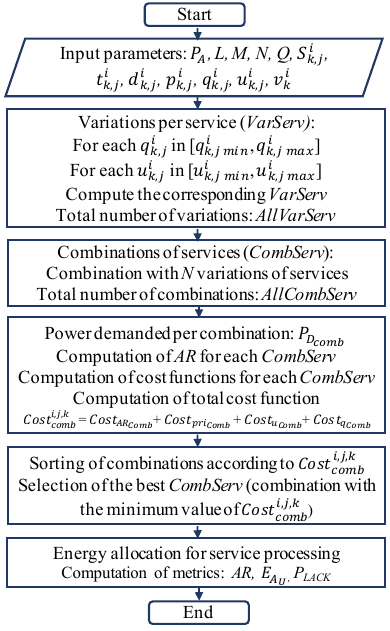
Figure 6. Flow chart of the exact algorithm strategy O PT T S